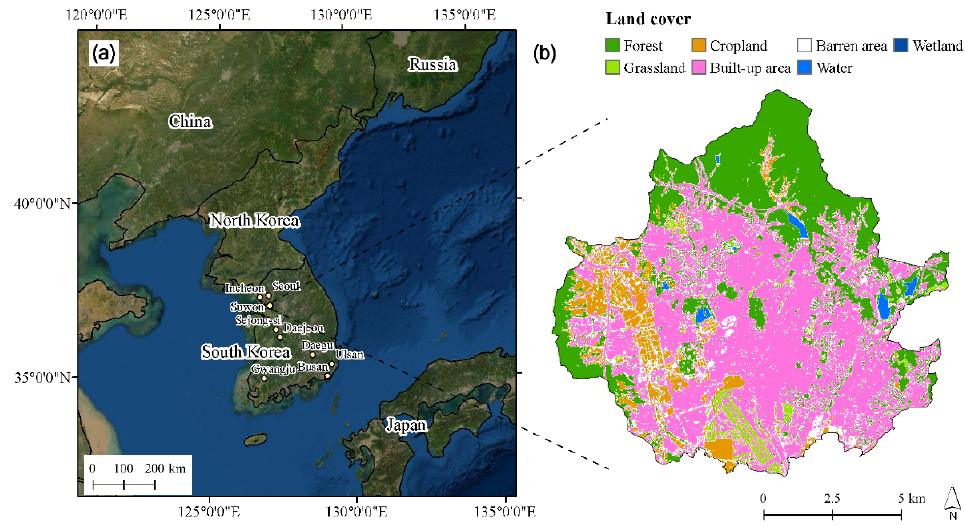
Figure 1. Geographical location and land cover map of Suwon City, Republic of Korea. ( a ) Aerial view of the Korean Peninsula in Northeast Asia [35]. ( b ) Land cover map of Suwon City, Republic of Korea [36].